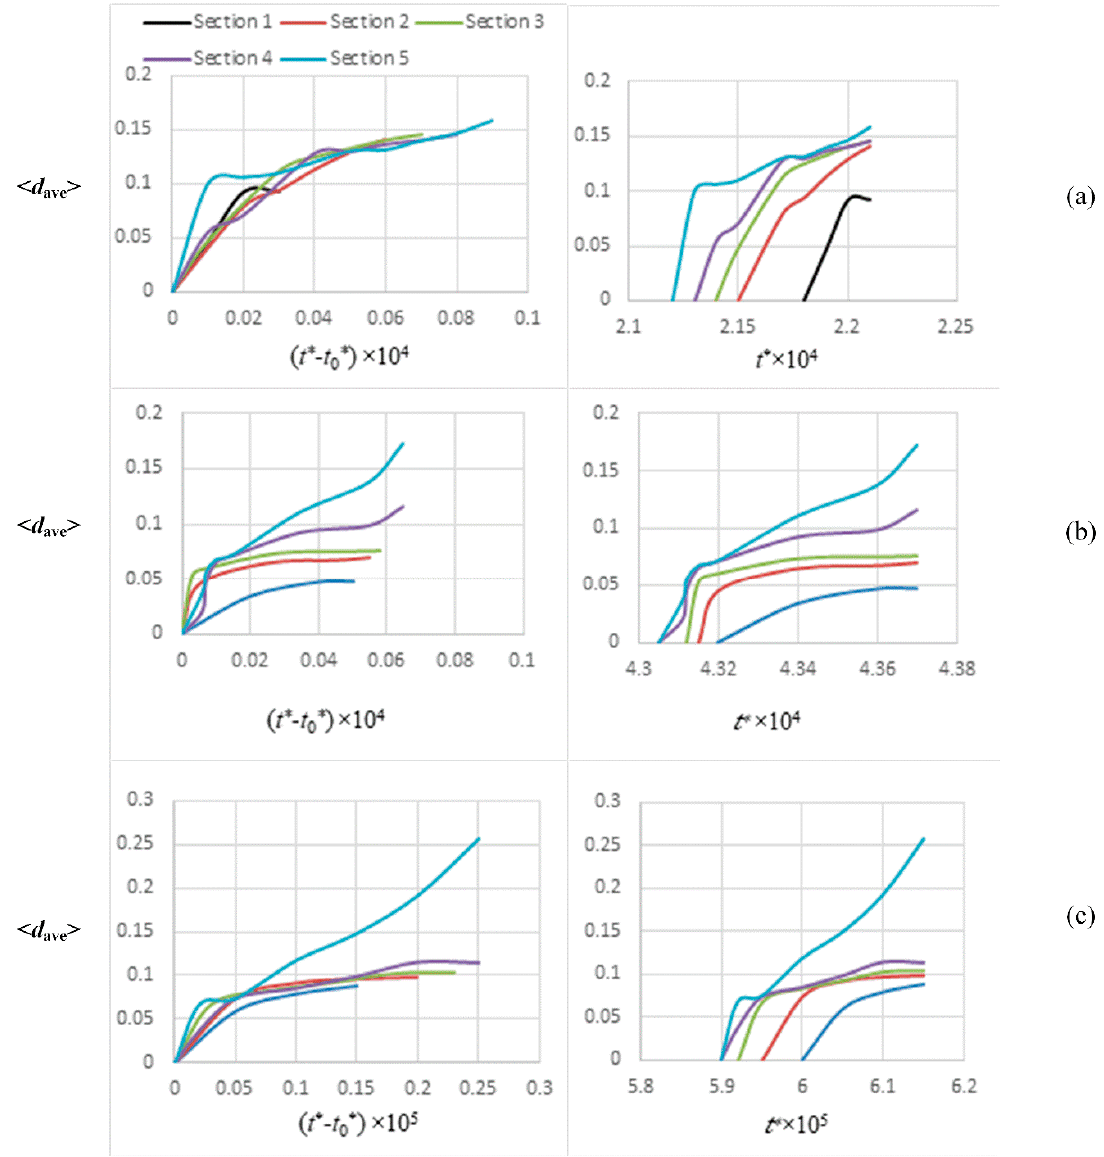
Figure 10. The average equivalent diameter of droplets developed within the five sections of a sample. Figures in rows a , b , and c represent Cases 1, 4, and 5, respectively. The left column is scaled according to t * – t 0* , where t 0* is the polymerization lag time; the right column is scaled based on the t * .